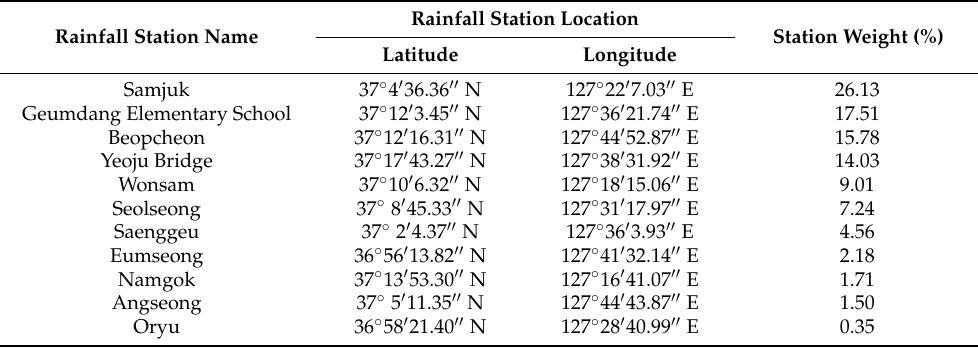
Table 1. Rainfall Station and Thiessen